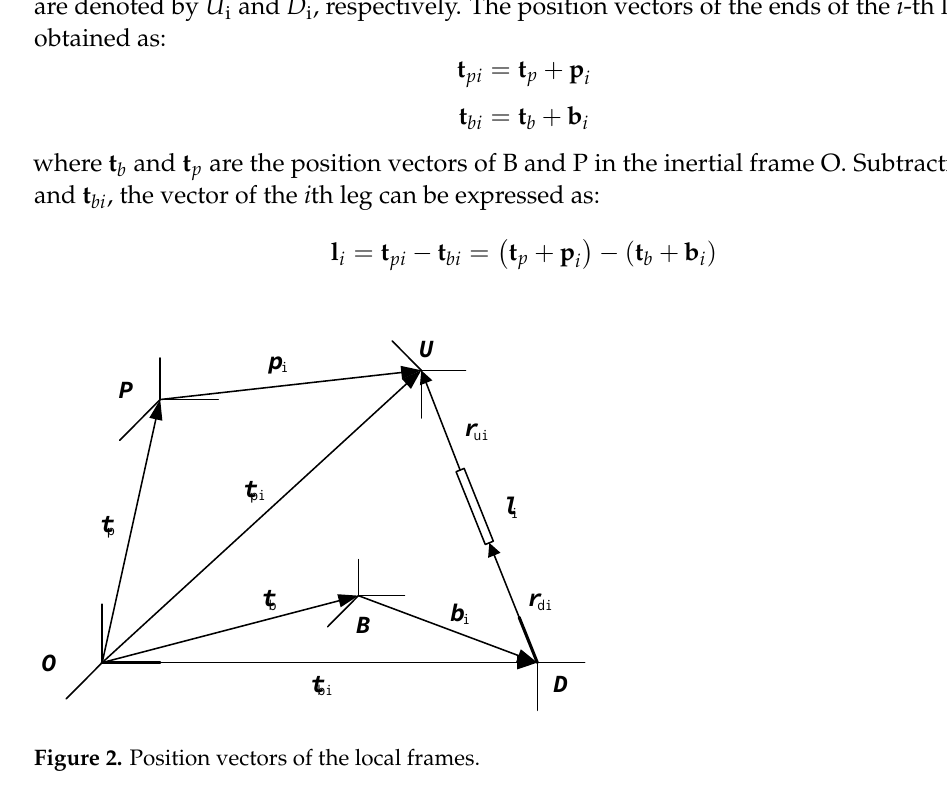
Figure 1. The composition of the platform.